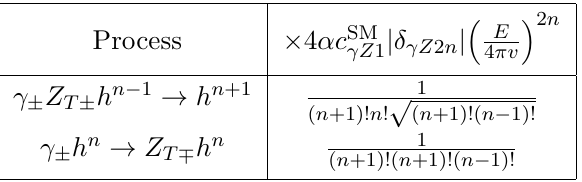
Table 8 . | ˆ M | of the 2 n + 2 -body model-independent unitarity-violating processes arising from the modification of the Higgs coupling to γZ